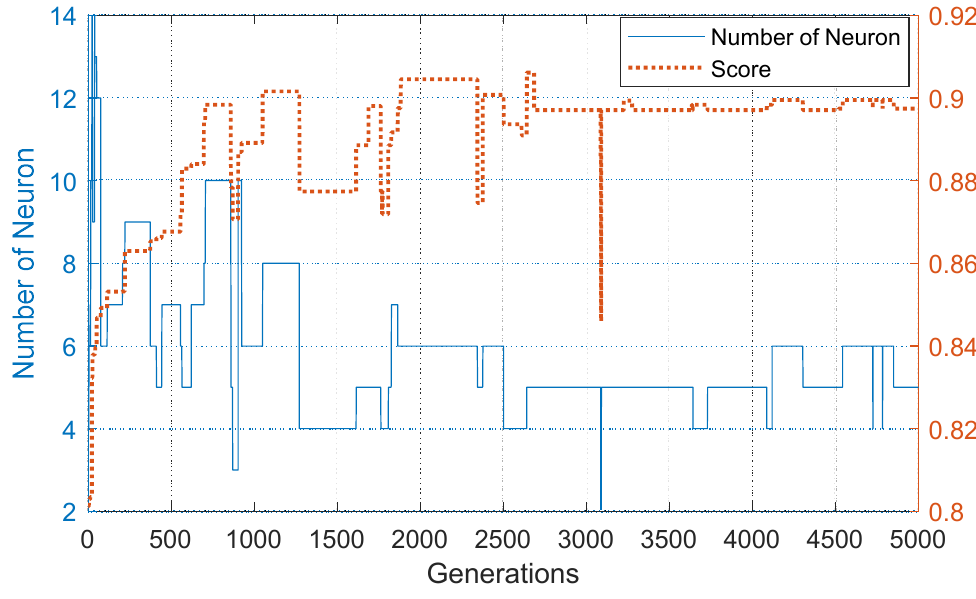
Figure 7. Auto-design process of DNN using NAS.